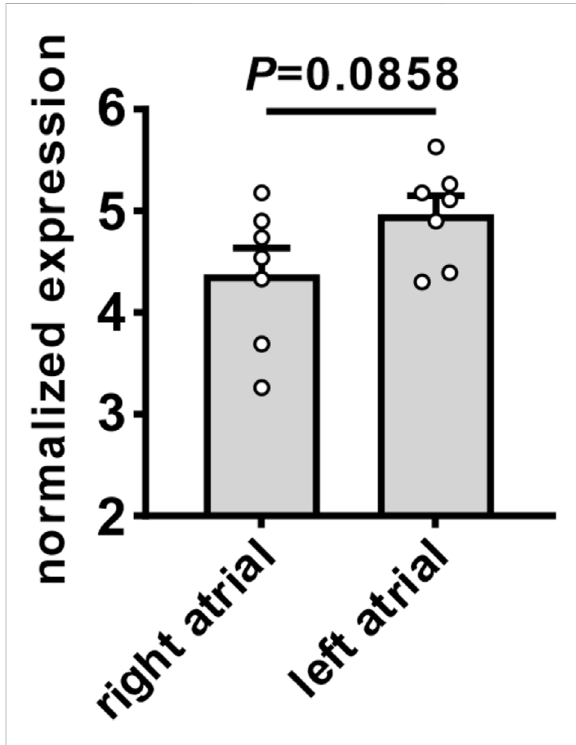
FIGURE 11 Expression of angiotensin II type 1 receptor in the right and left atria of mice. Comparison of mRNA expression of AT1R in the right and left atria of untreated wildtype mice. Data analyzed by Student ’ s t -test; n =7 for right atrial and 7 for left atrial